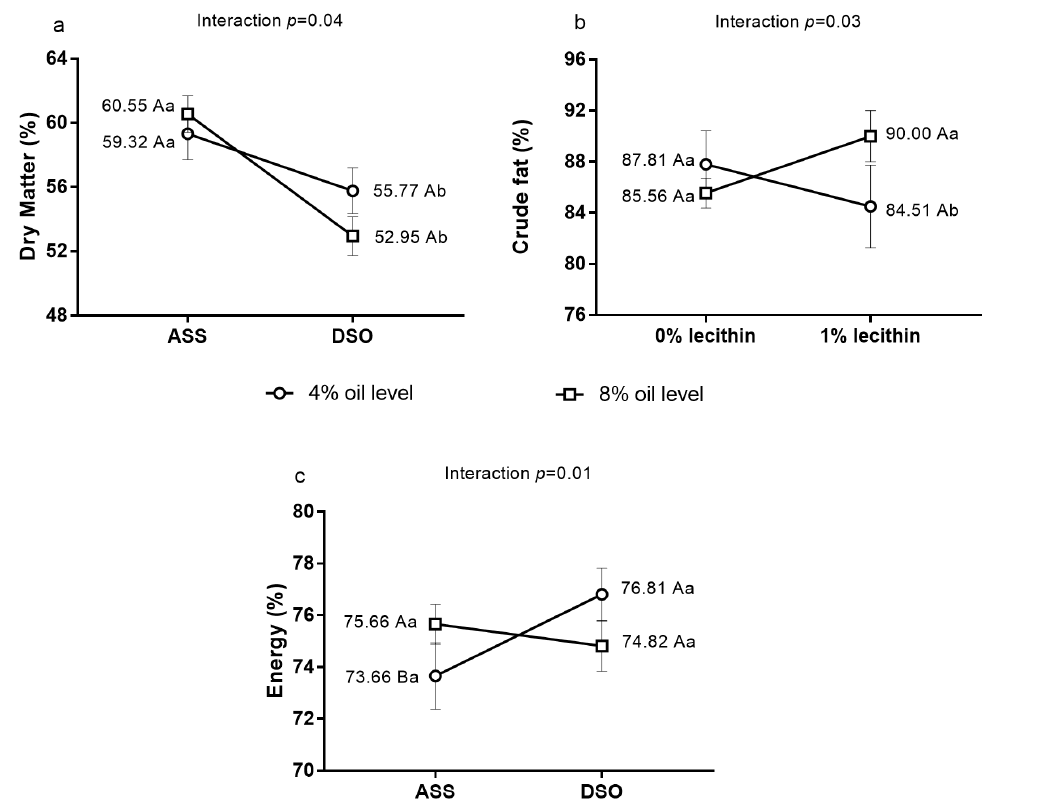
Figure 4. Effect of interaction between level of supplementation and type of oil, oil level and lecithin on digestibility of dry matter (4a), crude fat (4b) and energy (4c). (a) and (c): Different lowercase letters are significantly different between type oil; Different capital letters are significantly different between oil levels; (b): Different lowercase letters are significantly different between presence or absence of the lecithin; Different capital letters are significantly different between oil